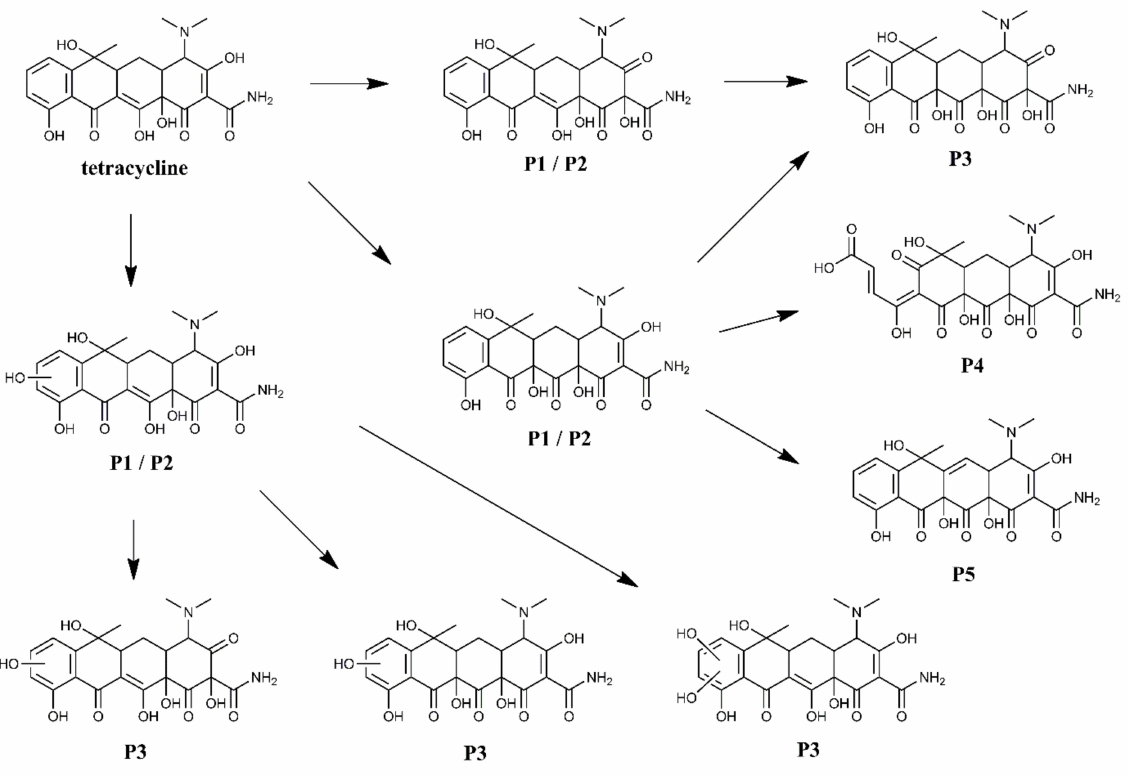
Figure 3. Suggested TRC degradation pathway [27,54,58] including the products identified in the current